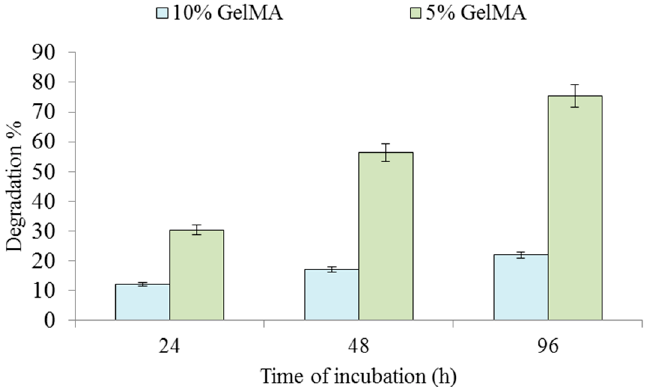
Figure 6. Swelling ratios with an increase in incubation time for 5% and 10% GelMA hydrogels. The error bars indicate the standard deviation